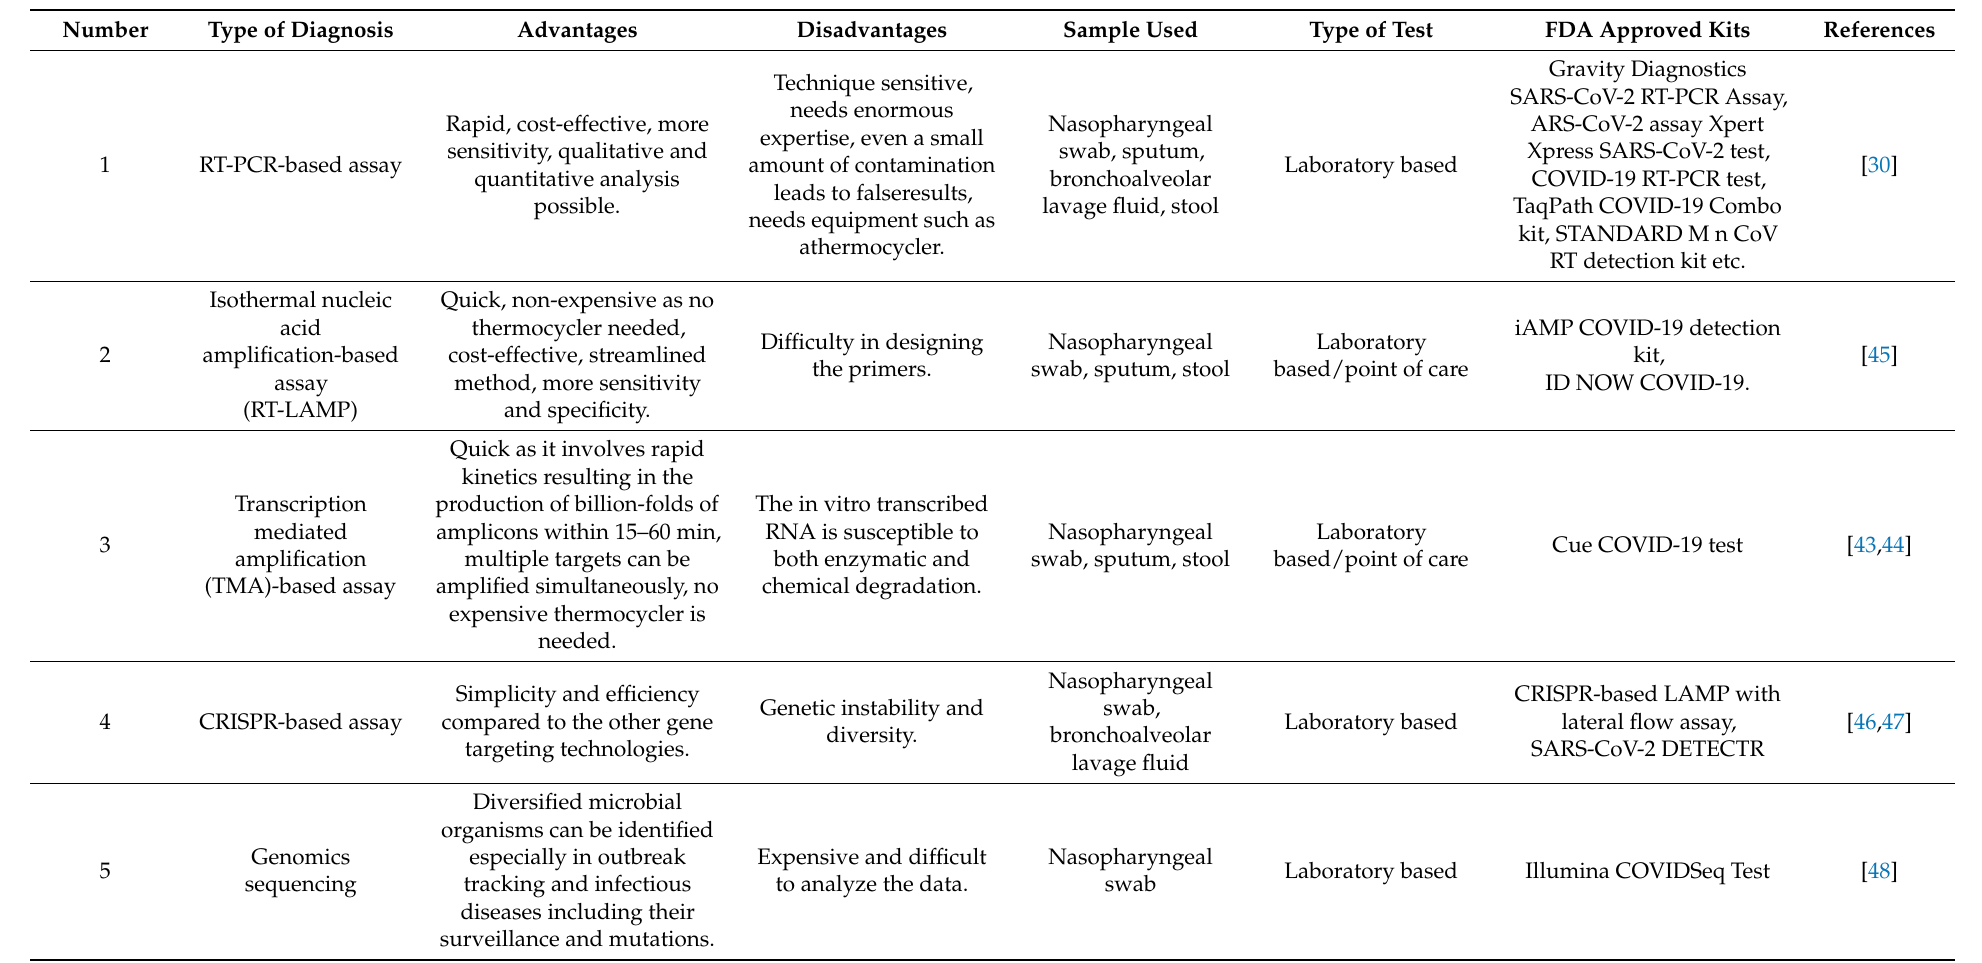
Table 1. Characteristic Features of Various Diagnostic Tests used for Detection of SARS-CoV-2-Based